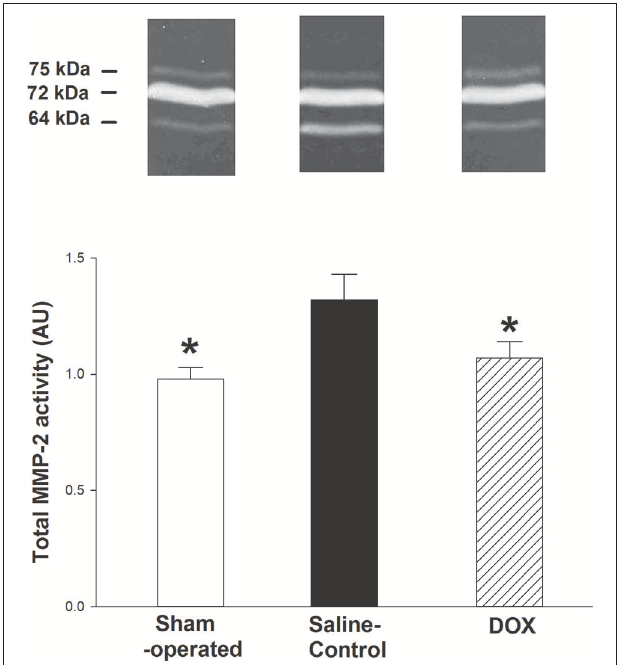
FIGURE 5 | Representative zymographs of MMP-2 activity in renal tissues of hypoxic piglets after 4 days of reoxygenation, which either received saline (saline-control) or DOX. Sham-operated piglets had no hypoxia and reoxygenation. All values represent mean ± SEM. * p < 0.05 vs. saline-controls (one-way ANOVA).